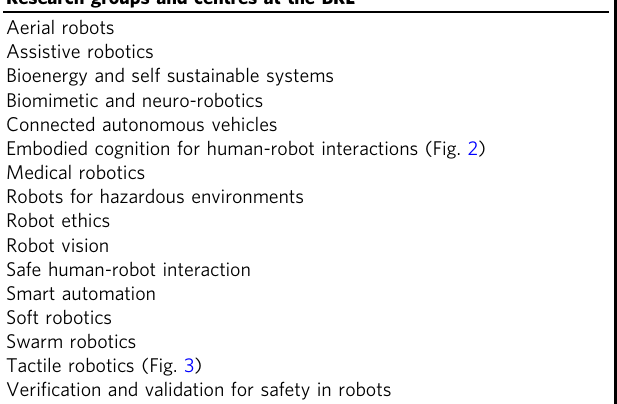
Table 1 Research groups and centres at the BRL.